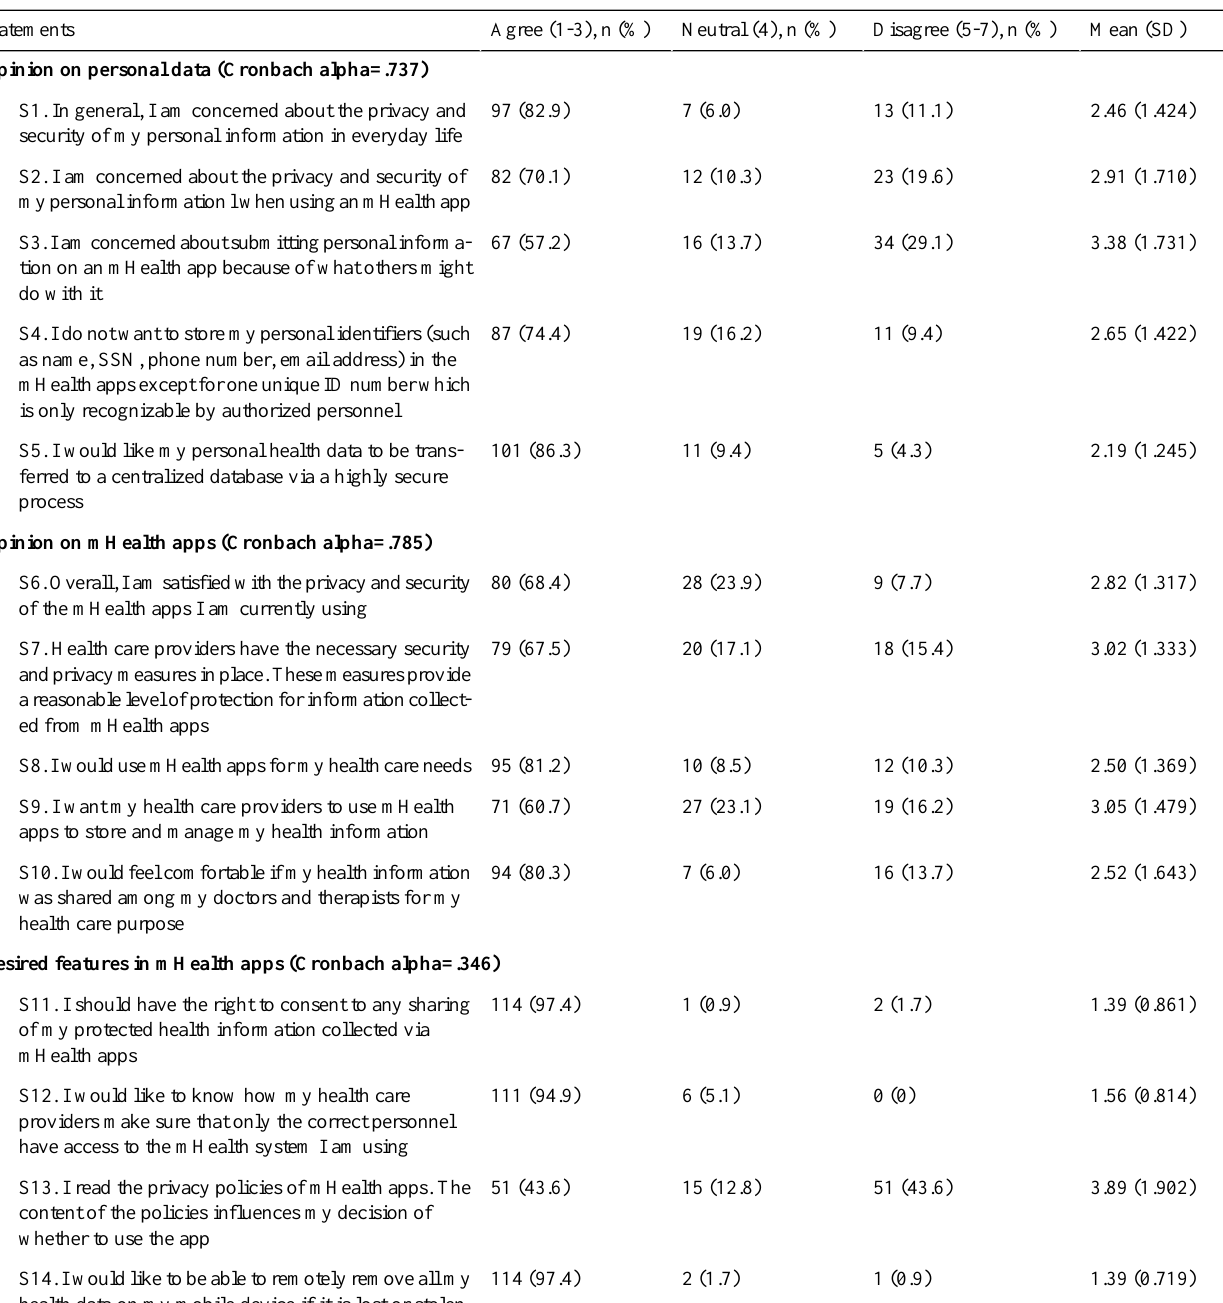
Mean (SD)Disagree (5-7), n (%)Neutral (4), n (%)Agree (1-3), n (%)Statements